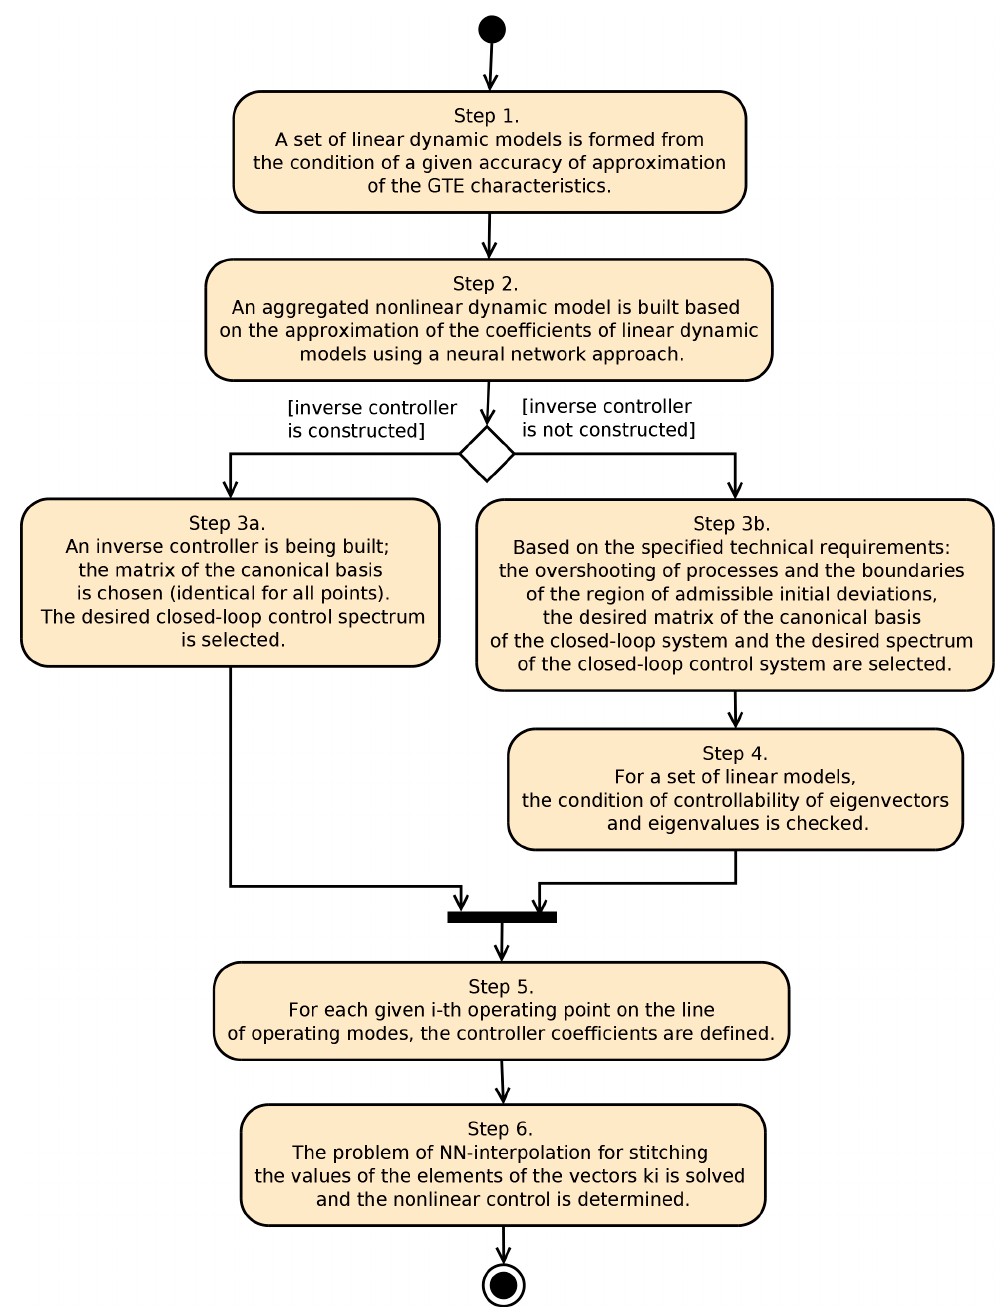
Figure 4. Diagram of the nonlinear control design algorithm for the gas turbine engine (GTE).